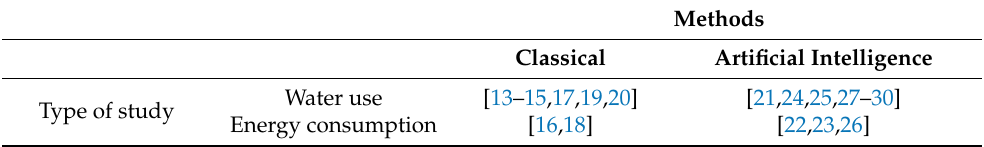
Table 1. Synthesis of the literature